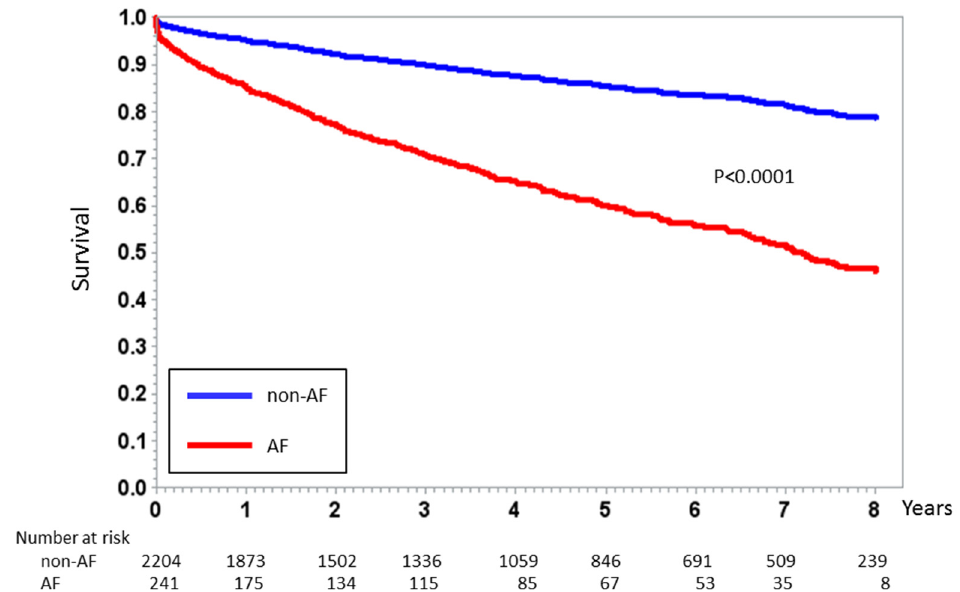
Figure 2. Kaplan–Meier curve analysis of all-cause mortality stratified according to new-onset AF occurrence during the index event in the entire study population. p value by Log rank test.